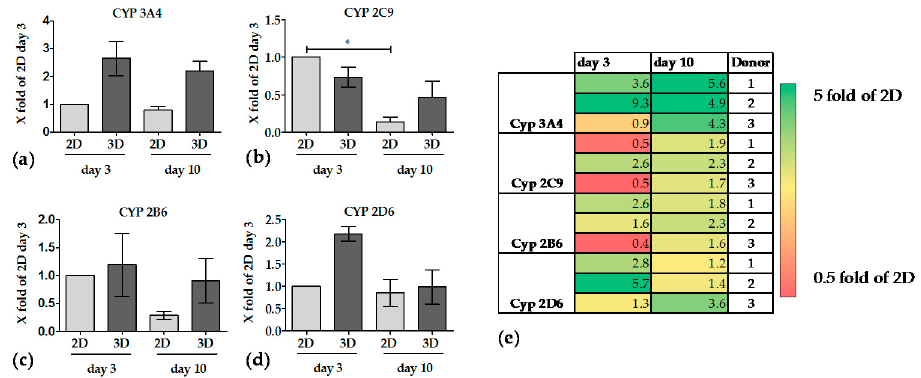
Figure 6. Activity of CYP enzymes, which are involved in drug metabolism. Supernatants were collected after incubation with specific substrates as indicated in Materials and Methods at days 3 and 10 of culture. ( a – d ) shows the CYP activities of CYP 3A4, 2C9, 2B6 and CYP 2D6. Values of 2D cultures are summarized in bright bars. Values of 3D cultures are summarized in dark bars. Bars represent mean ± SEM of three independent experiments (N = 3, n = 3) * p ≤ 0.05 as indicated. ( e ) Overview of the individual donor differences is represented in a heat map showing the CYP activities in 3D cultures compared to 2D cultures.